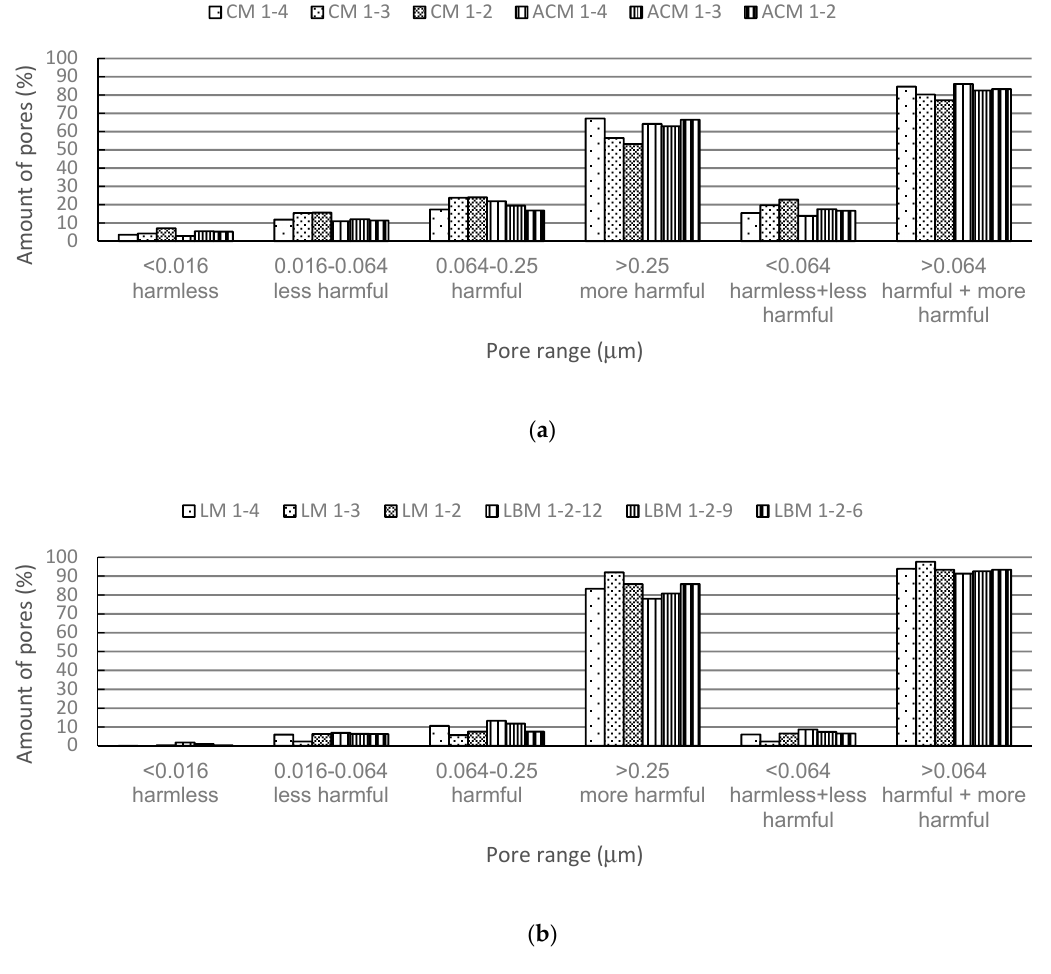
Figure 1. Pore groups with respect to their harmfulness ( a ) in cement and aerated cement mortars and ( b ) in lime and lime based mortars.